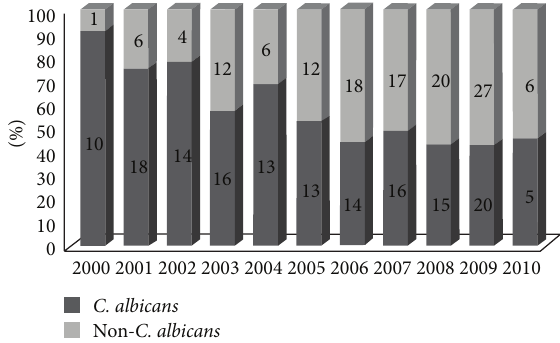
Figure 1: Proportion of C. albicans versus non- C. albicans species during the study period.